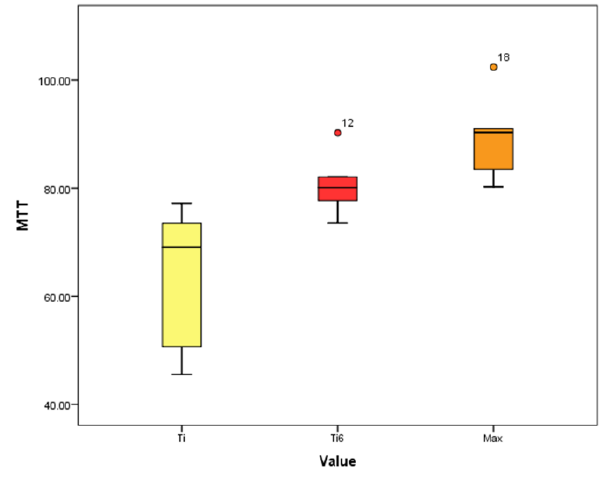
Figure (2) Cell viability of CPT(Ti), Ti 6 Al 7 Nb (Ti6) and Ti 2 AlC(max) after 72